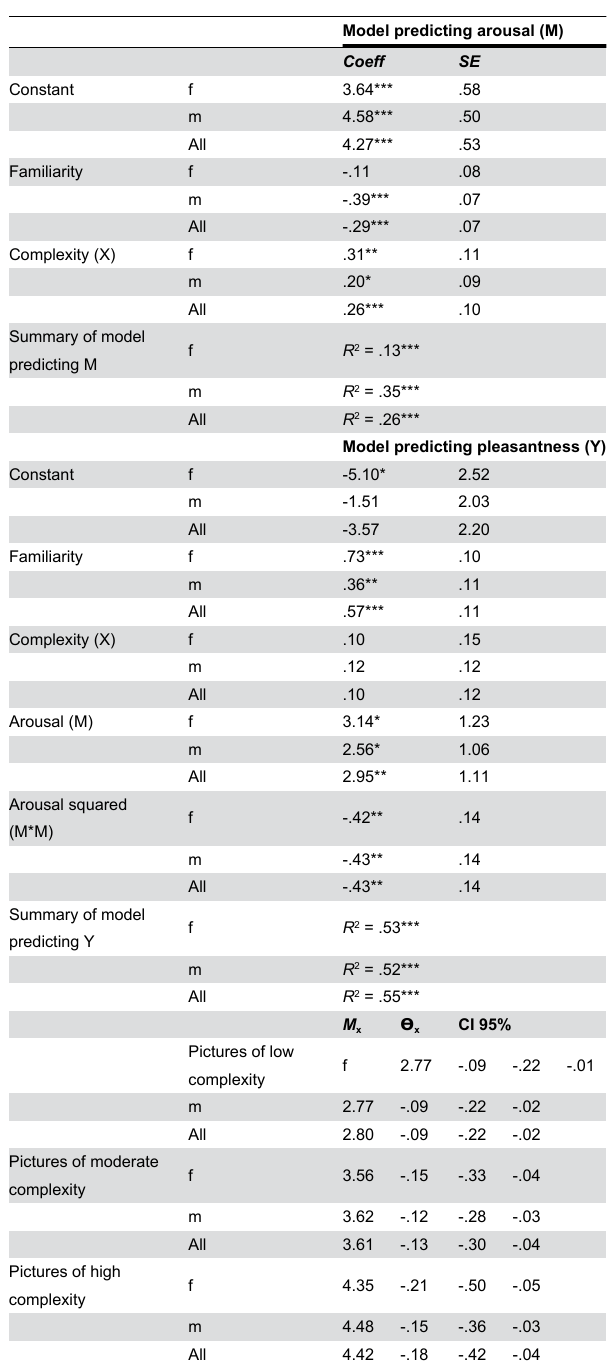
Table 2. Indirect effect of complexity (X) on pleasantness (Y) through arousal (M) calculated for IAPS pictures (N 94, n = 92, n = 92), modeled with a quadratic males females relation between M and Y and familiarity as a